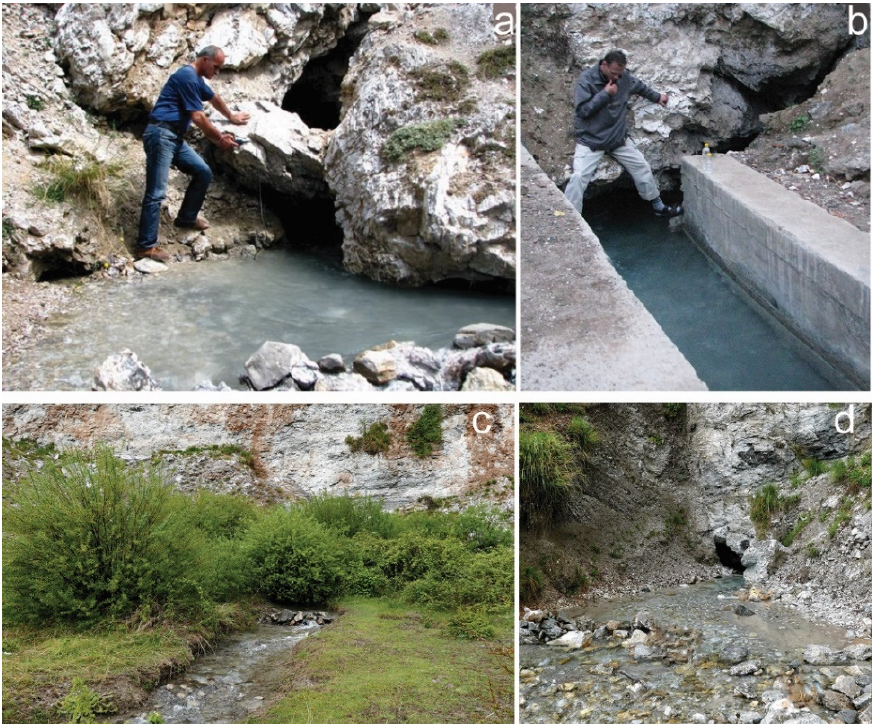
Figure 3. Brackish springs in the Peshkopia area: ( a ) Konri (no. 2 in Figure 2); ( b ) Brezhdani (no. 3 in Figure 2); ( c ) Gypsum (no. 4 in Figure 2); and ( d ) Vlesha (no. 8 in Figure 2). Table 2. Basic characteristics of brackish cold springs in Korab Mountain area (Figure 2).